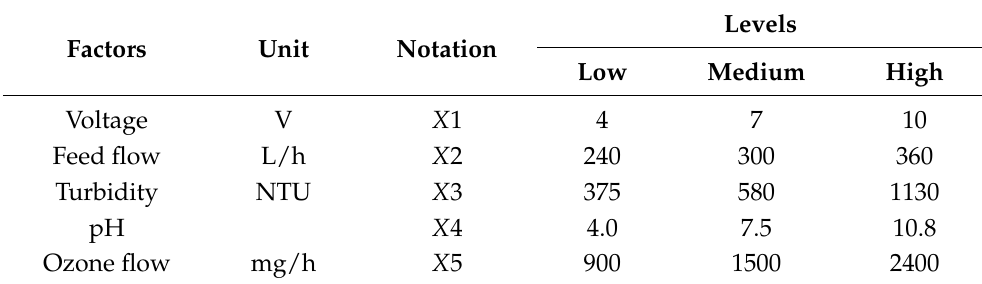
Table 2. Experimental range and levels of independent variables used in this study.